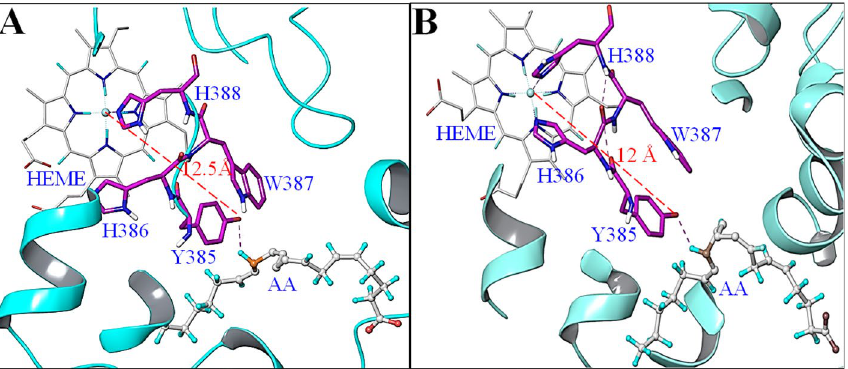
Figure 2. ( A ) Crystal coordinates of COX-2–AA as available in the protein data bank. The distance between the Fe and oxygen of Y385 is 12.5 Å. ( B ) A pose of MD trajectory of COX-2–AA complex showing no much change in relative placement of active site components.